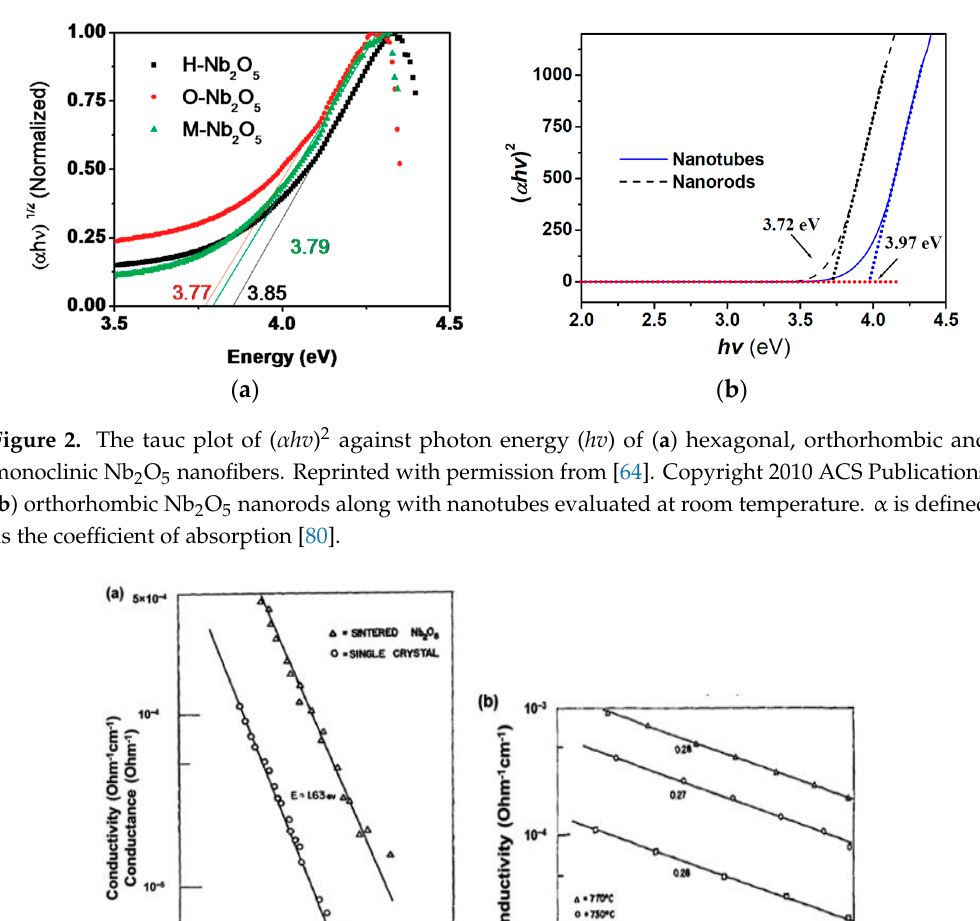
Figure 1. Structural stages of H-Nb 2 O 5 , O-Nb 2 O 5 and M-Nb 2 O 5 , together with the Nb 2 O 5 crystal phase evolving with respect to temperature [75].